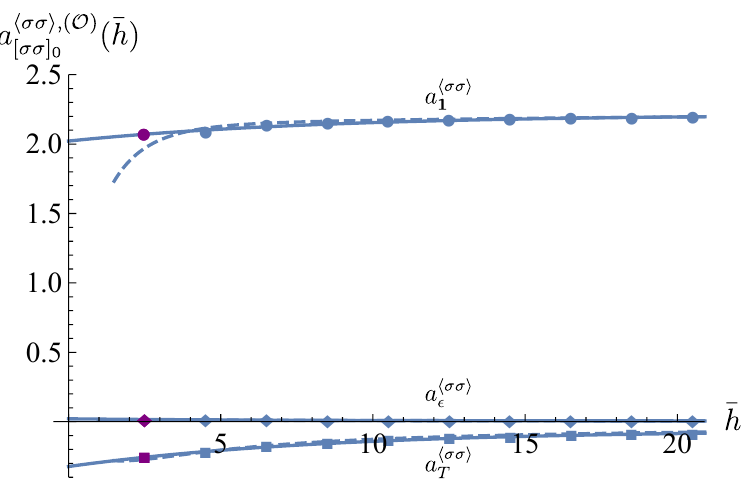
Figure 12. Estimates for the terms multiplying a h (cid:27)(cid:27) i a h (cid:27)(cid:27) i ( J ). The dashed blue curves are the predictions from the inversion formula before performing [ (cid:27)(cid:27) ] 0 operator mixing while the solid curves are the predictions after accounting for operator mixing. The blue dots represent the post-mixing predictions for each local operator with J (cid:21) 4 in the [ (cid:27)(cid:27) ] 0 family. The purple dots are the extrapolation of the thermal coe(cid:14)cient to the stress-energy tensor.